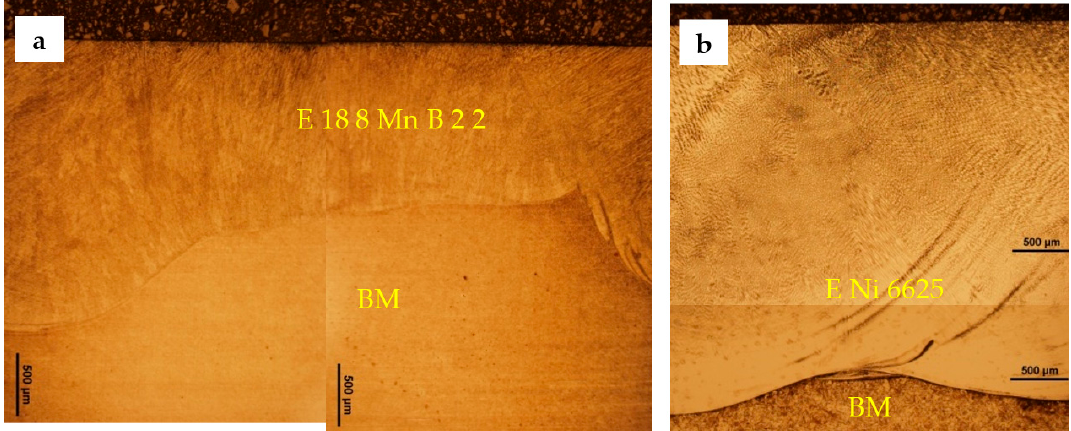
Figure 4. Three-layer welded clads of ( a ) E 18 8 Mn B 2 2 and ( b ) E Ni 6625 deposited on the BM. Immersion Test